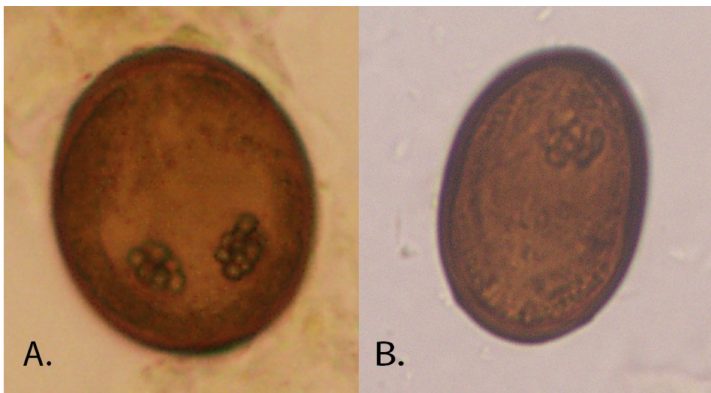
Figure 2. Platynosomum fastosum egg in ( A ) bile and ( B ) sugar flotation